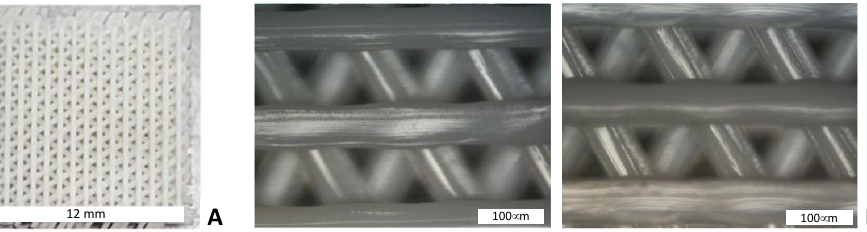
Figure 3. Representative image of a 3D-printed PLA scaffold ( A ) and morphological observations ( B ).